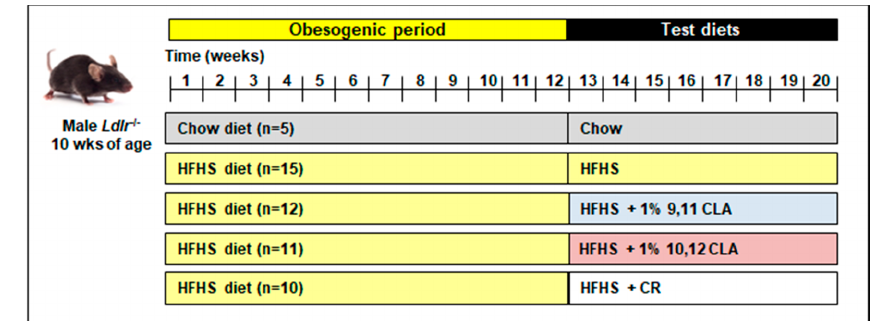
Figure 1. Study schematic. 10-week male low-density lipoprotein receptor deficiency ( Ldlr − / − ) mice were fed either a chow or obesogenic high-fat, high-sucrose (HFHS) diet for 12 weeks, then either maintained on those diets or switched to a HFHS diet containing 1% 9,11 conjugated linoleic acid (9,11 CLA) ( w/w ), 1% 10,12 conjugated linoleic acid (10,12 CLA) ( w/w ), or calorically restricted (CR) on the HFHS diet to consume 85% of baseline food intake for an additional 8 weeks. wks: weeks.